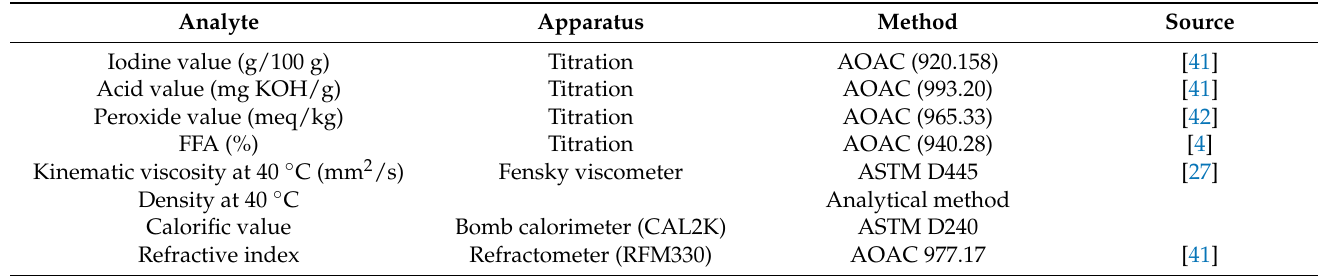
Table 1. Analytes and test methods for quality of biodiesel and biodiesel